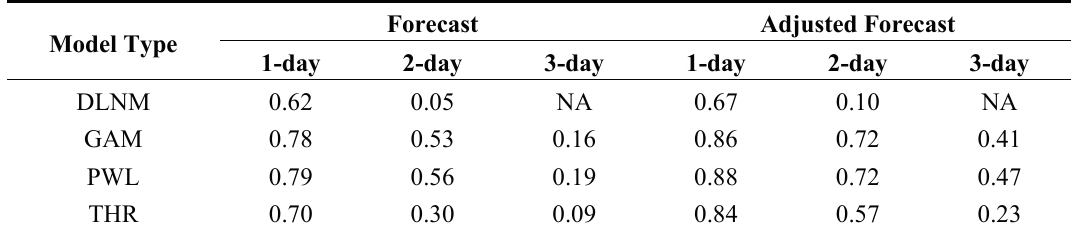
Table 2. Sensitivity scores for the four models using forecast and adjusted forecast temperatures, and different issuing time